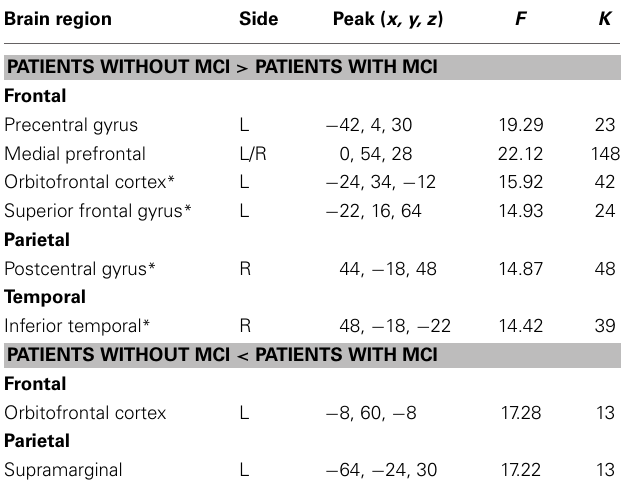
Table 2 | Main effects of group in BOLD-signal intensity between patients with Parkinson’s disease with and without MCI.